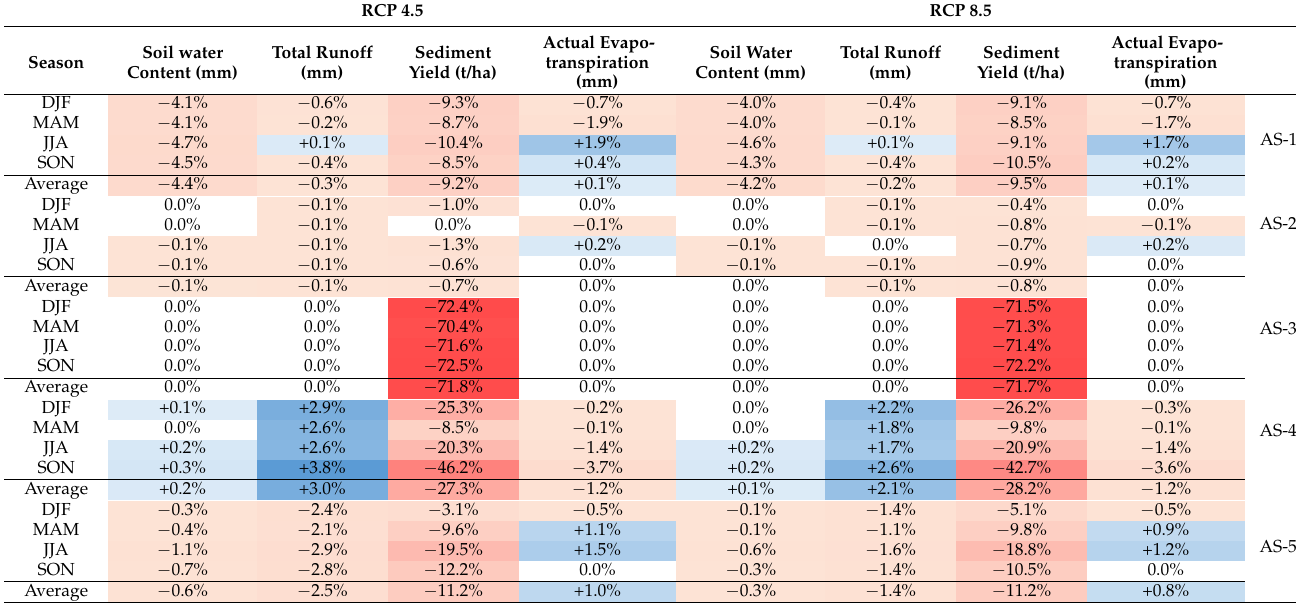
Table 10. Percent summary of changes in soil water content, sediment yield, total runoff and actual evapotranspiration under adaptation scenarios 1–5 (AS-1, AS-2, AS-3, AS-4, AS-5) compared to scenario 0 (S-0) (created from Supplementary Material: Figures S1 and S2), for averages of three GCMs/RCMs combinations under two RCP climate change scenarios (RCP 4.5, RCP 8.5). The summary is for four seasons (DJF, MAM, JJA, SON) in the Bystra catchment. Shaded numbers indicate percentage changes (red indicates % decrease in content, and blue indicates % increase